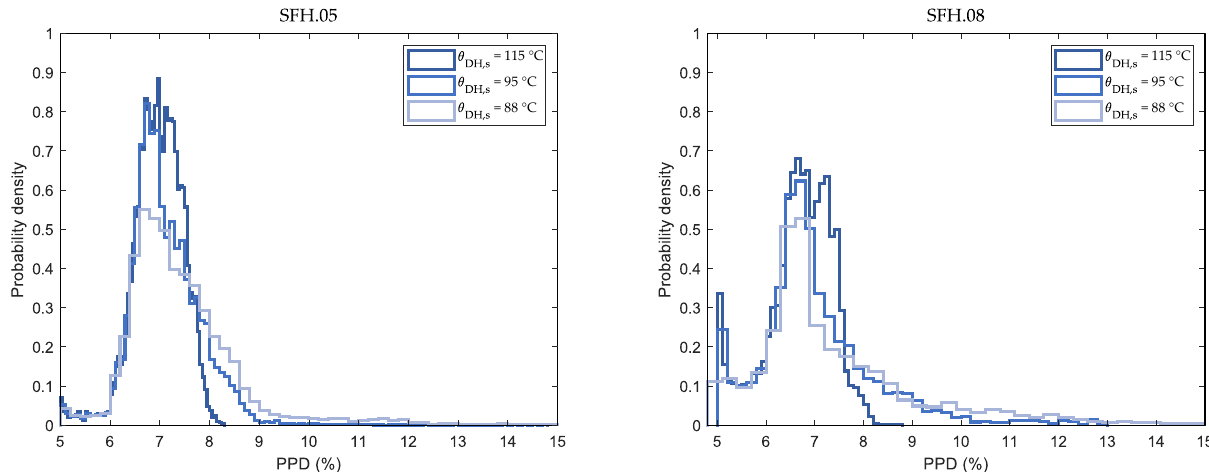
Figure 7. Distribution of predicted percentage of dissatisfied (PPD) over the heating season for single family house built between 1961–1975 ( left ) and built after 2006 ( right ), and decreasing DH supply